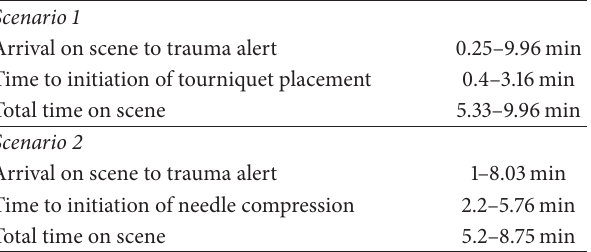
Table 3: Scene time ranges for trauma alert